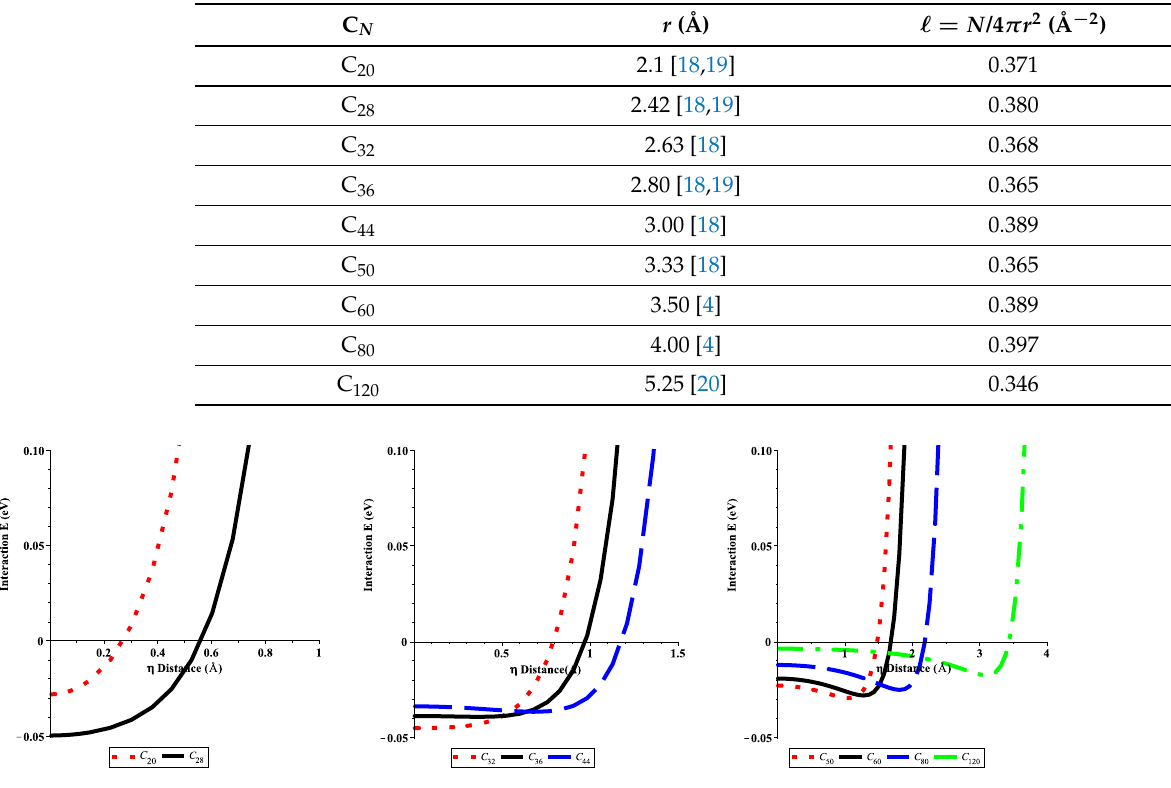
Figure 3. Interaction energies of an offset Li atom inside the C N fullerenes ( N = 20, 28, 32, 36, 44, 50, 60, 80, and 120) with respect to the radial offset distance η from the center of the fullerenes.